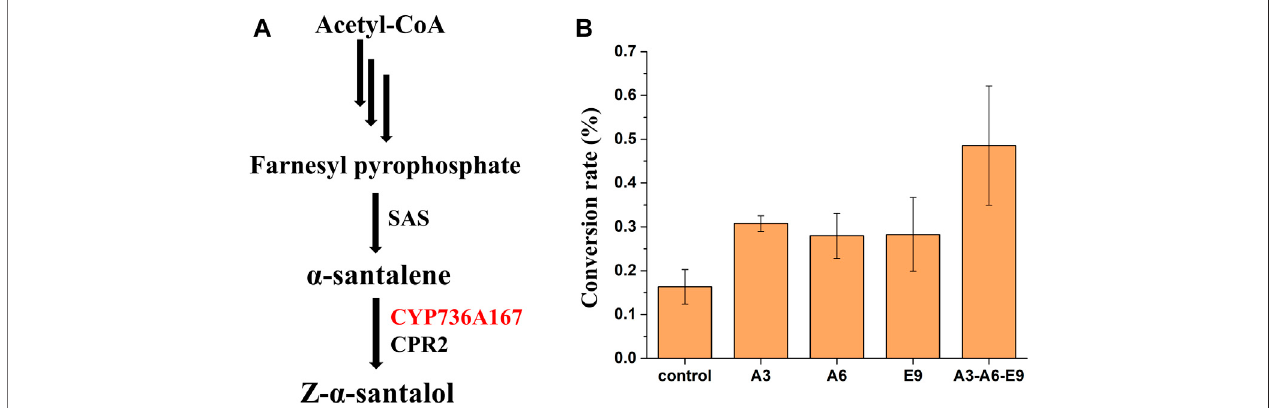
FIGURE 3 | The effects of AtGRP7 (A3), AtMSBP1 (A6), and AtCOL4 (E9) on the functional expression of CYP736A167 (shown in red) and accordingly the hydroxylation of α -santalene to produce Z- α -santalol. (A) The Z- α -santalol biosynthetic pathway from acetyl-CoA. (B) The effects of AtGRP7 (A3), AtMSBP1 (A6), and AtCOL4 (E9) on the α -santalene to Z- α -santalol conversion rate, either overexpressed alone (A3, A6, and E9) or in combination (A3-A6-E9). Error bars represented the mean ± s.d. of biological triplicates. SAS: α -santalene